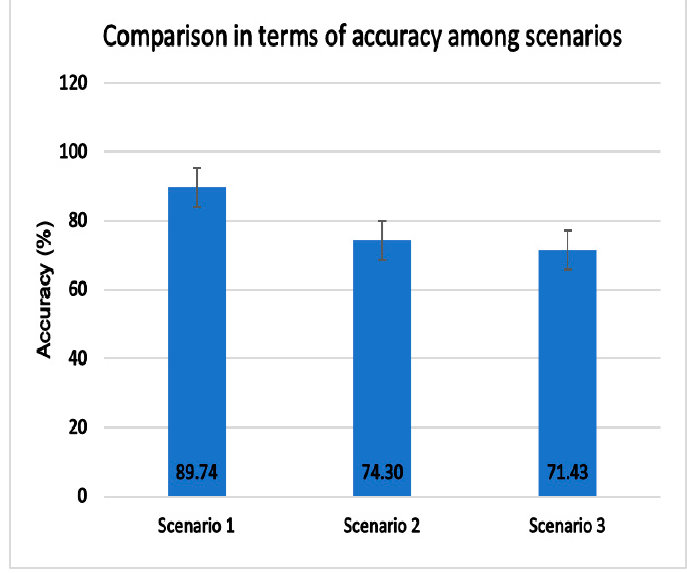
Figure 3. Comparison in terms of accuracy among scenarios.